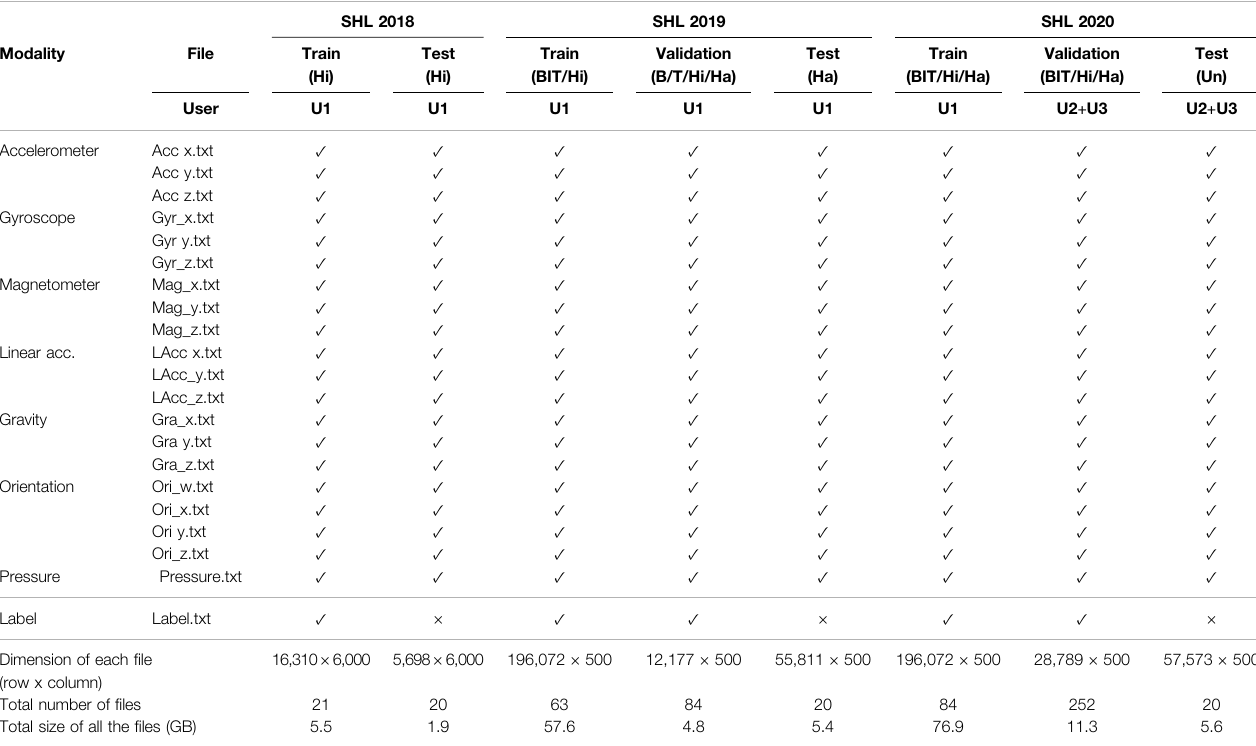
TABLE 3 | Data fi les provided by the SHL recognition challenges 2018 – 2020. Position: B — Bag; T — Torso; Hi — Hips; Ha — Hand; Un — Unknown position; U1 — User1; U2 — User2; U3 —